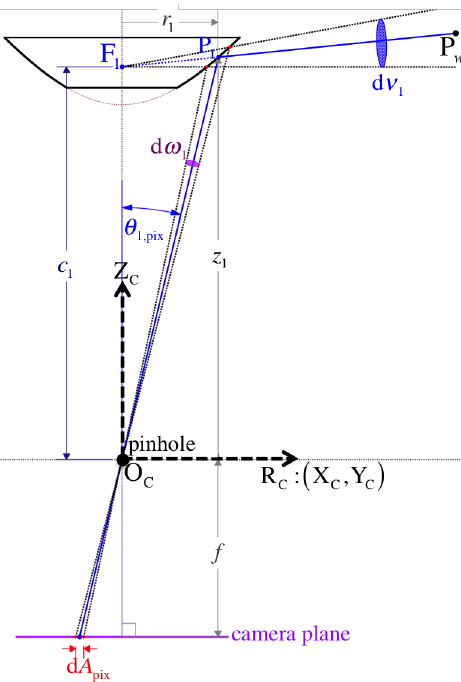
Figure 8. The spatial resolution for a central catadioptric sensor is the ratio between an infinitesimal image area d A and its corresponding solid angle d ν 1 that views a point P w